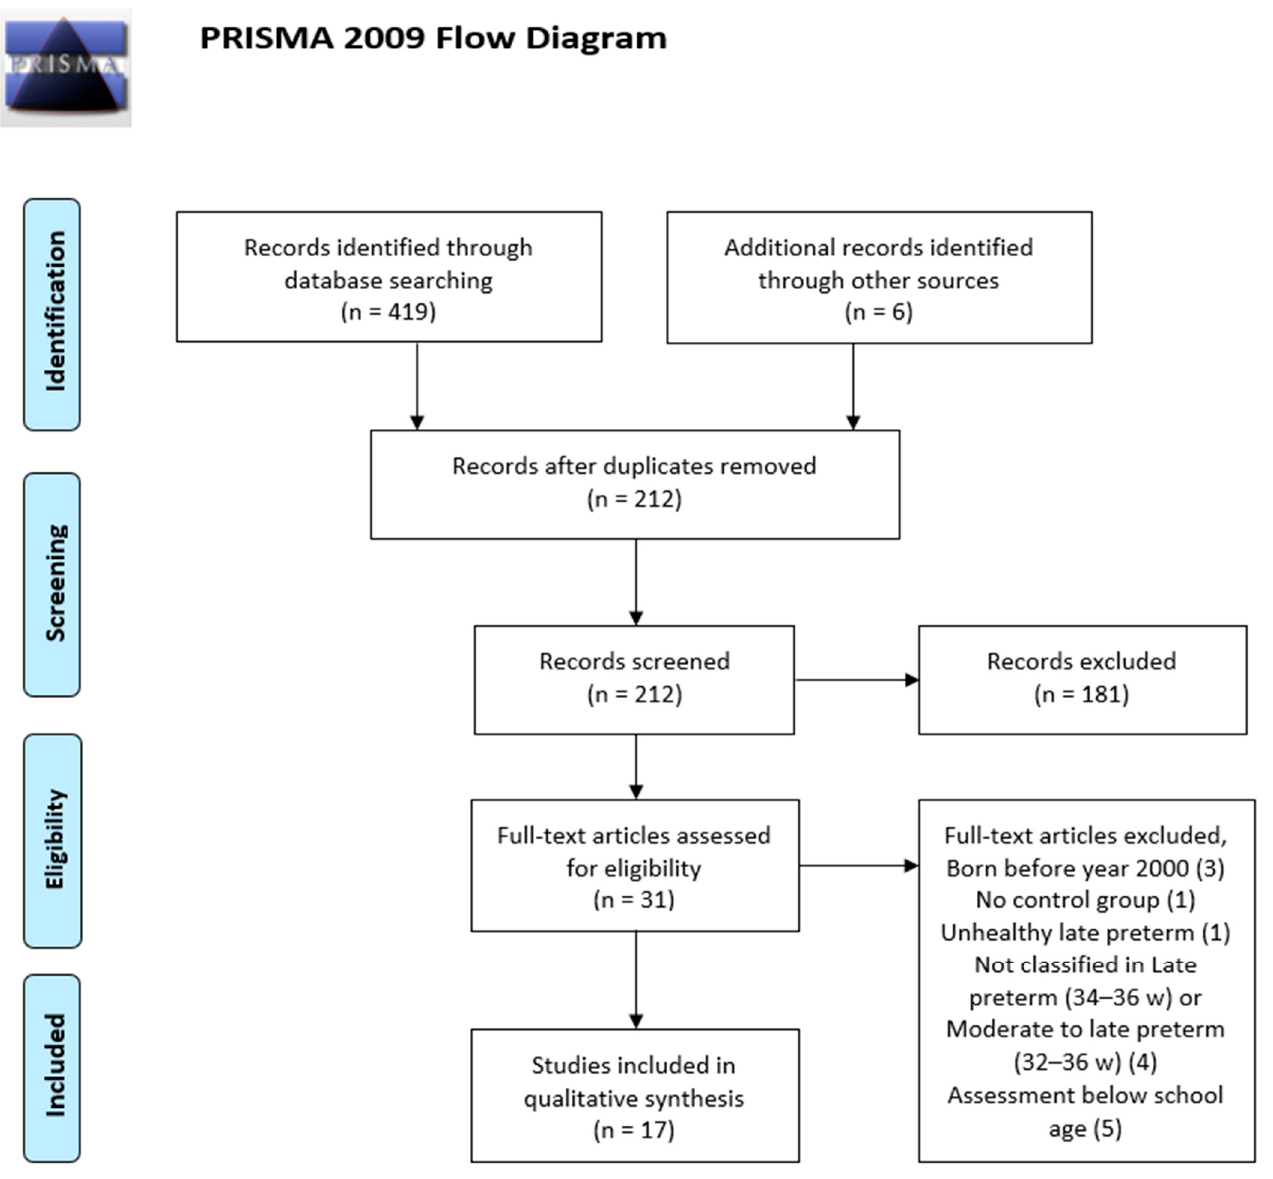
Figure 1. Flowchart showing the study selection process.